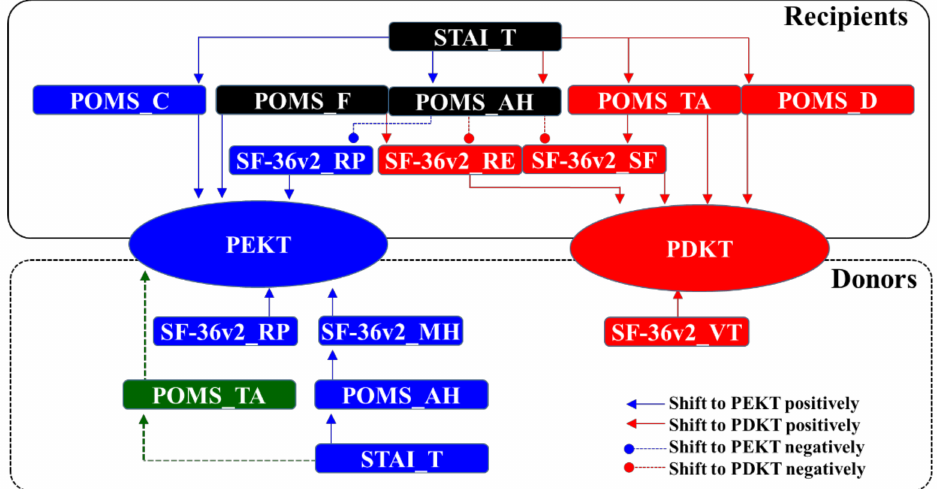
Figure 5. Proposed cascades of decision-making processes for PEKT and